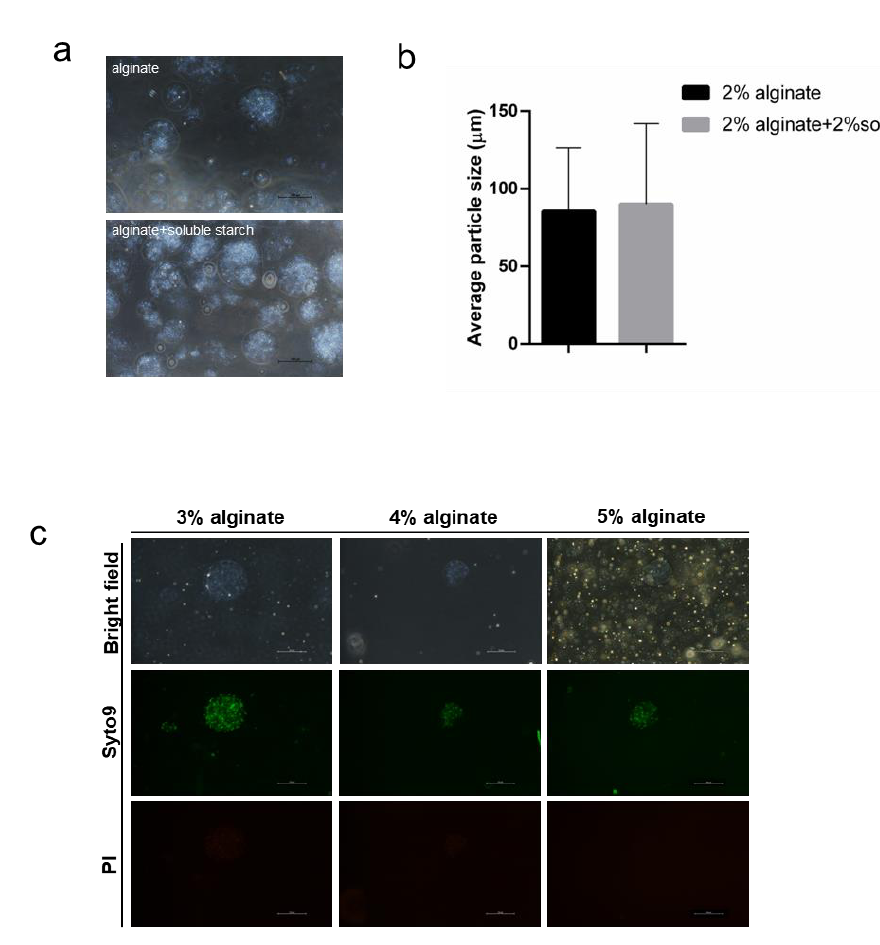
Figure 4. Morphology and mean particle size of the microspheres. ( a ). Morphology of sodium alginate microspheres embedded with L. gasseri . ( b ). Morphology of sodium-alginate-soluble starch composite microspheres encapsulated with L. gasseri . The scale bar corresponds to 100 µm.( c ). Effect of encapsulant on the size of droplet with L. gasseri . The scale bar corresponds to 100 µm .